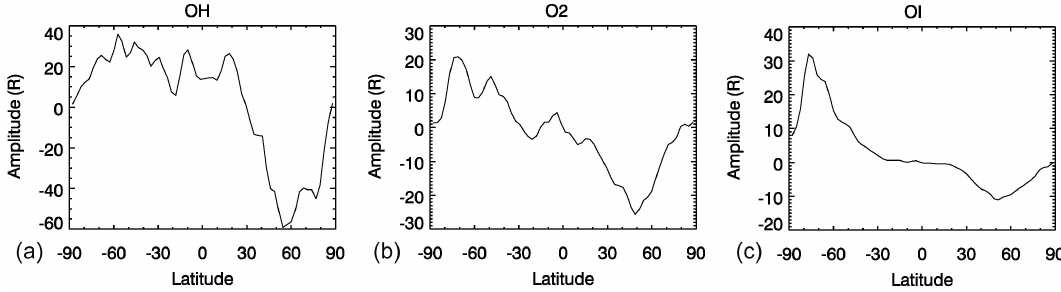
Figure 4. Latitudinal structure of the zonal wavenumber 1, westward-propagating 10-day